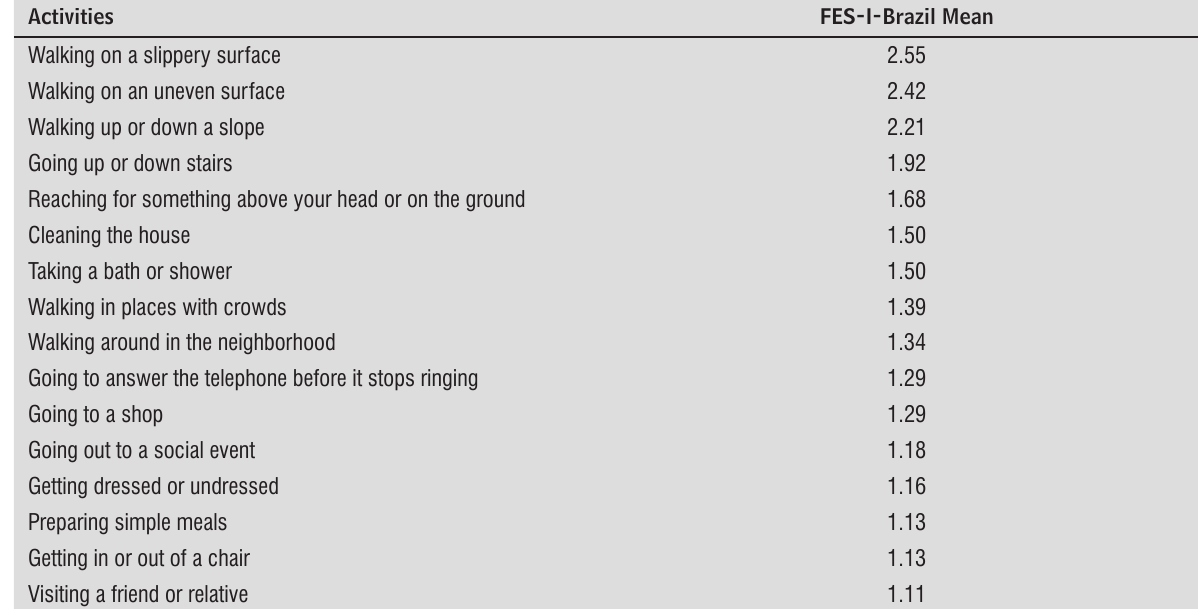
Table 1 - FES-I-Brazil mean of all participants for each activity